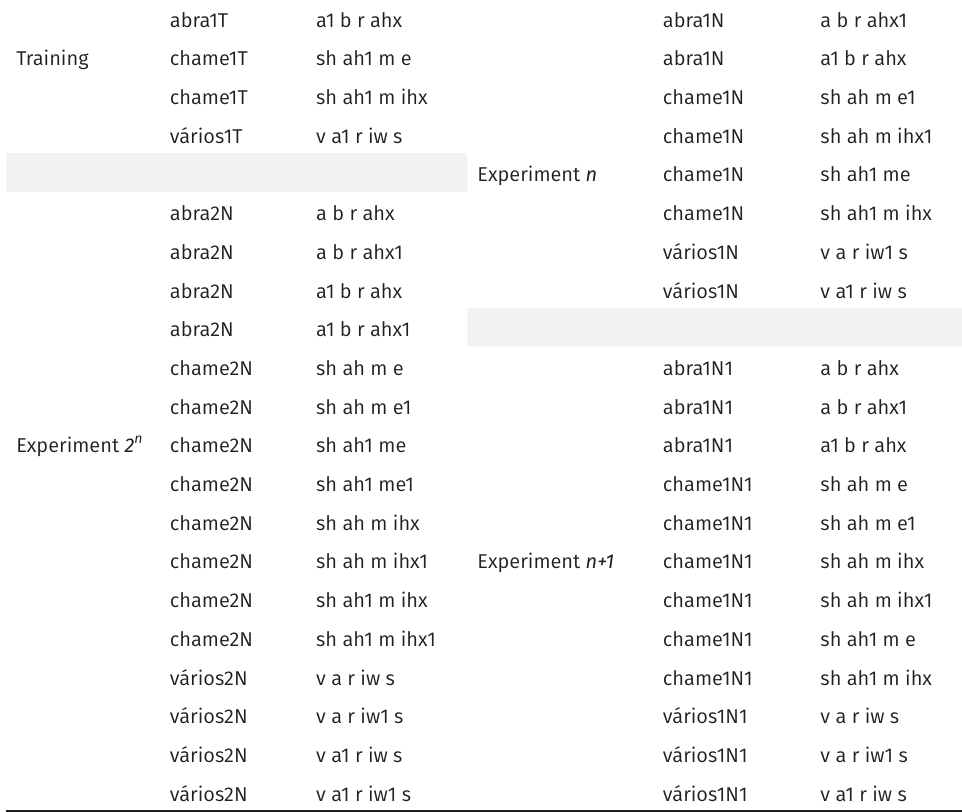
Table 6: Stress Placement in the different renditions of Lexicon. abra1T a1 b r